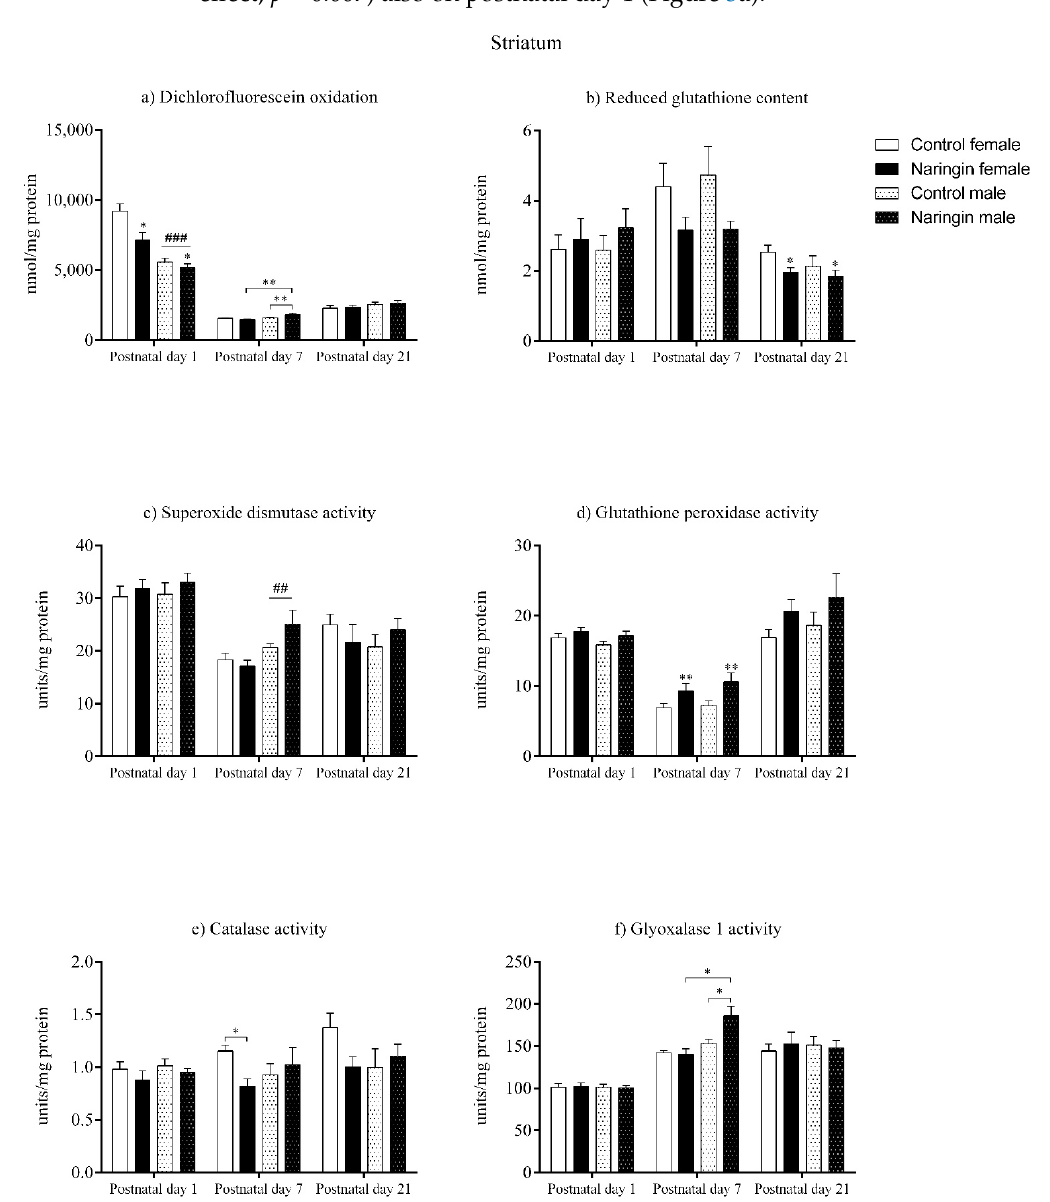
Figure 3. Effects of maternal naringin supplementation during the third week of gestation on the ( a ) dichlorofluorescein oxidation, ( b ) reduced glutathione content, ( c ) superoxide dismutase activity, ( d ) glutathione-peroxidase activity, ( e ) catalase activity, and ( f ) glyoxalase 1 activity in the offspring’s striatum on postnatal day 1, 7 and 21. Results are expressed as mean ± S.E.M. Control female n = 8, naringin female n = 8, control male n = 8, naringin male n = 6. * p < 0.05; ** p < 0.01; ## p < 0.01; ### p < 0.001 (two-way ANOVA). Asterisks represent a main supplementation effect, and the hashes on bars represent a main sex effect. The asterisks on bars (single bracket) represent the significant comparisons by Sidak’s post-hoc test when interactions occurred.